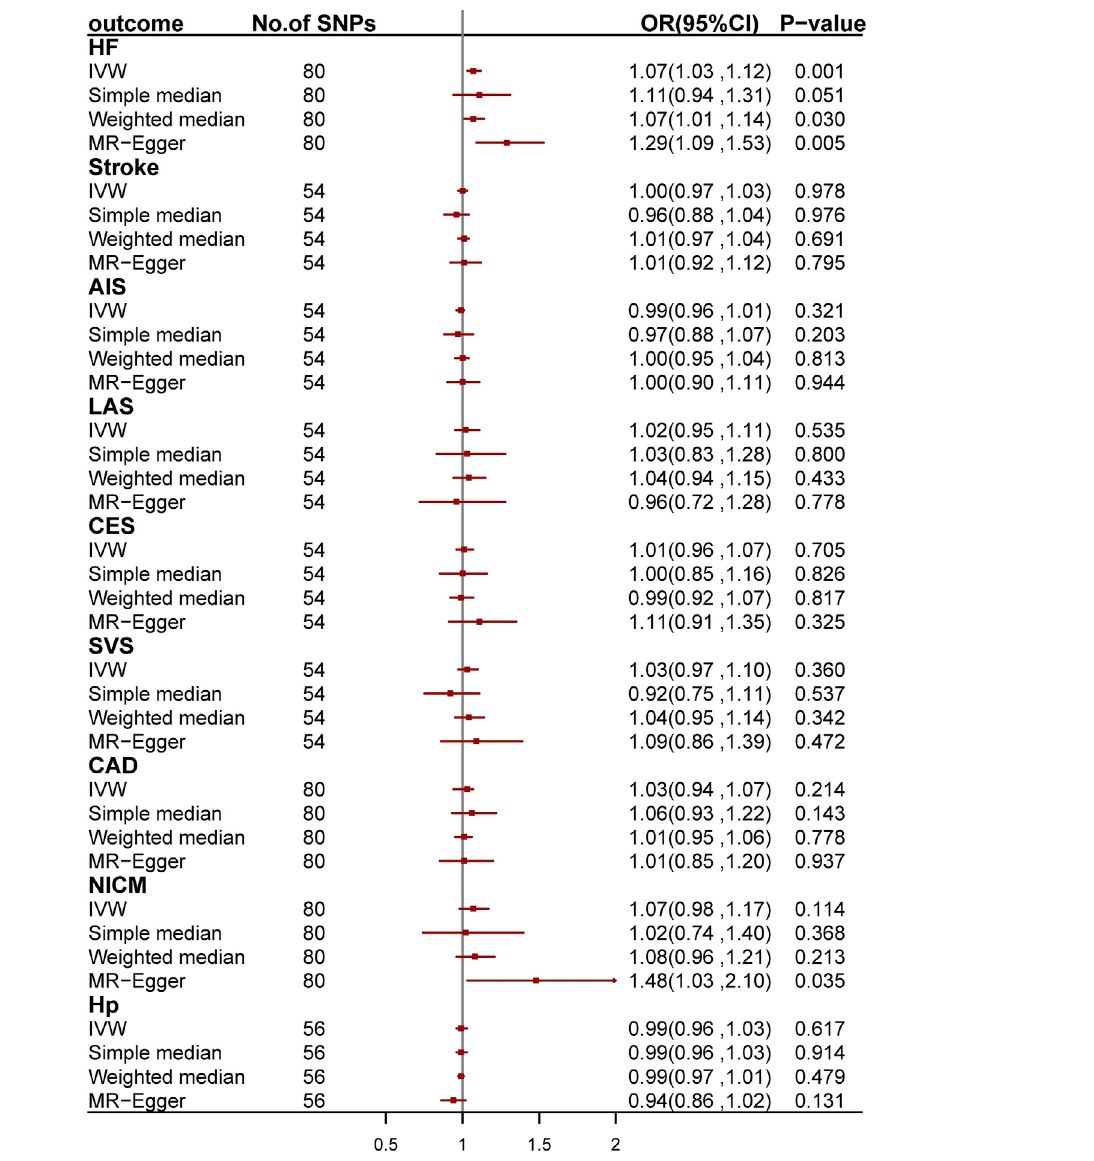
FIGURE 4| Odds ratio for the association among genetically predicted asthma and cardiovascular-related traits. OR, odds ratio; 95%CI,95%con fi dence interval; AIS, any ischemic stroke; CES, cardioembolic stroke; LAS, large-artery stroke; SVS, small-vessel stroke; CAD, coronary artery disease; HF, heart failure; NICM, non- ischemic cardiomyopathy; Hp,